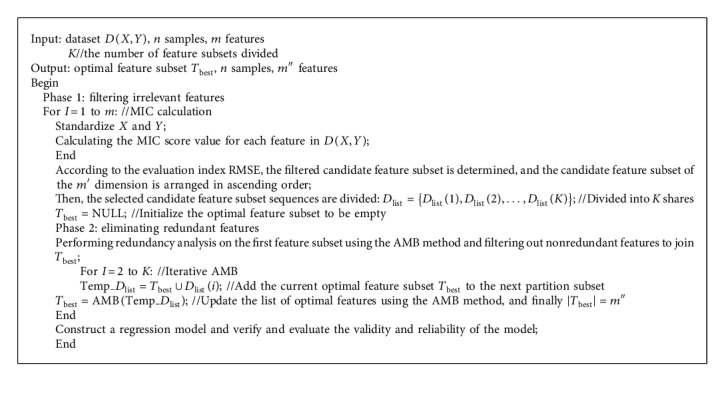
CI_AMB algorithm.